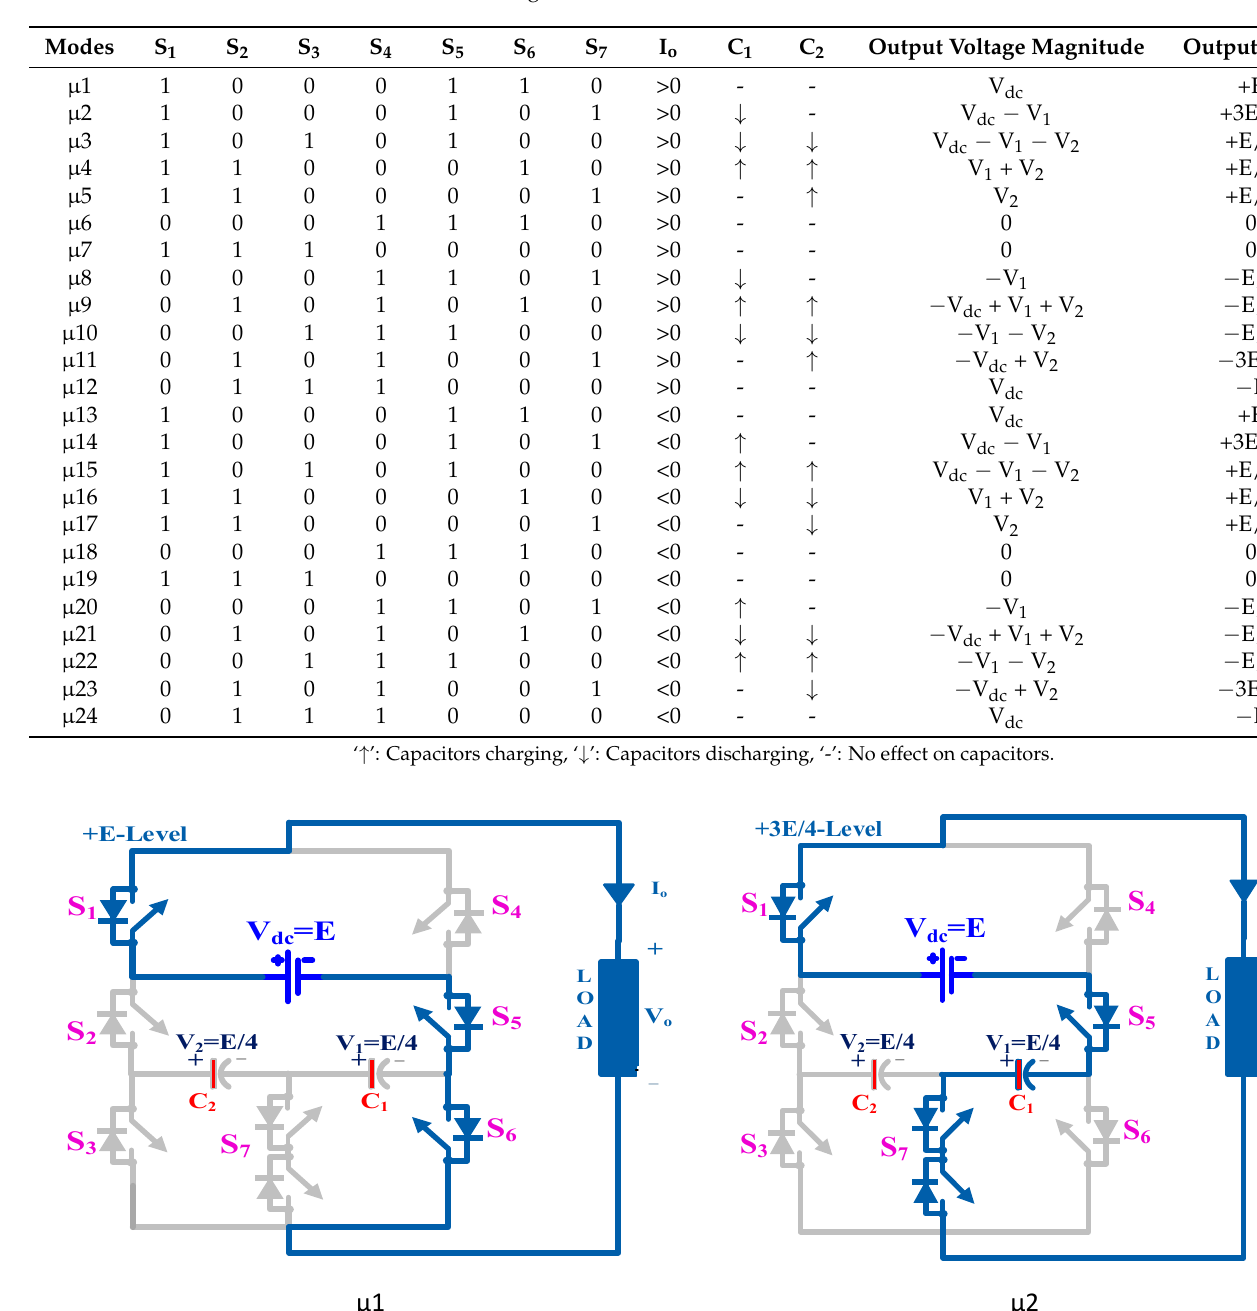
Table 1. Switching States of the nine-level PEC9 MLI.